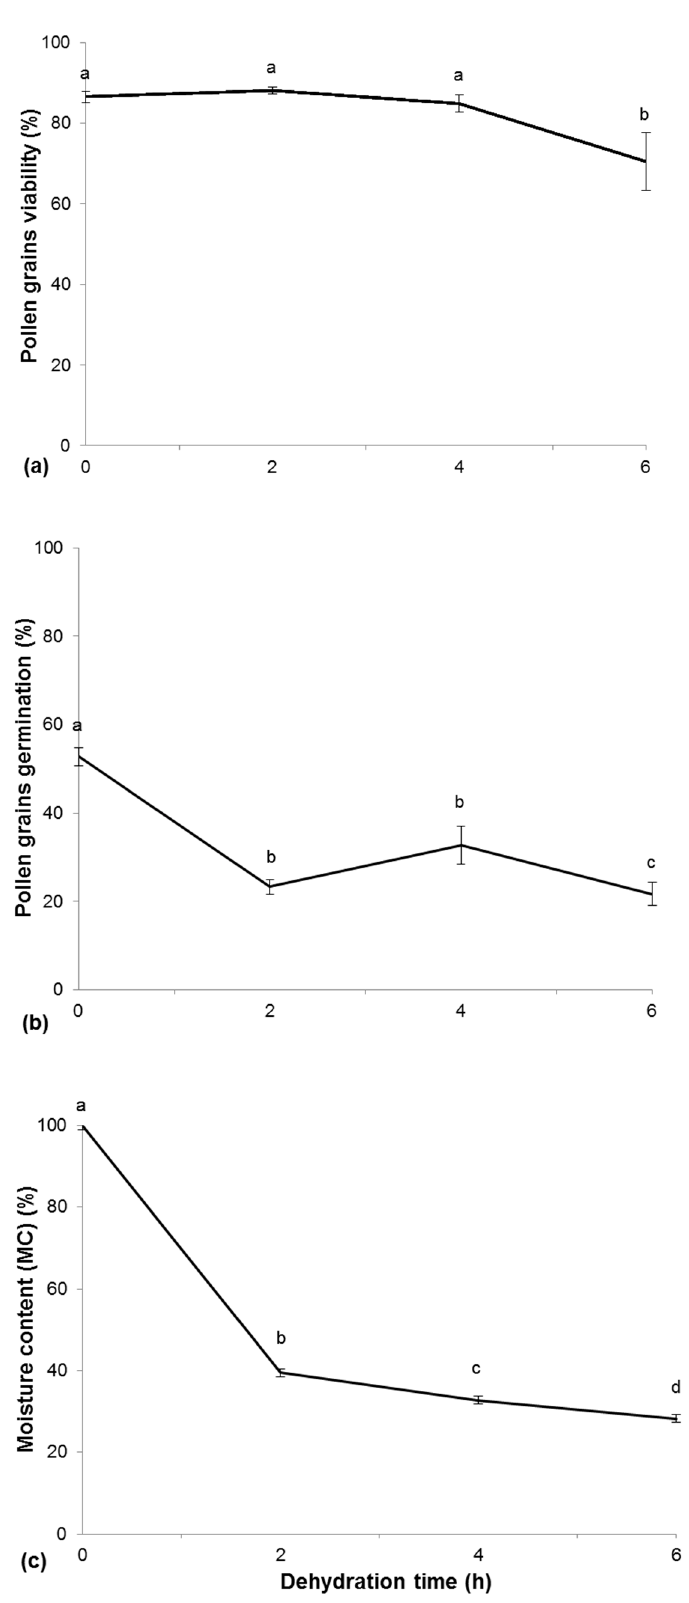
Figure 1. ( a ) Viability percentage of pollen grains; ( b ) The percentage of germination of pollen; ( c ) Moisture content (MC), after dehydration in silica gel for 0, 2, 4 and 6 h. The lowercase letters used in the graph to show significant statistical di ff